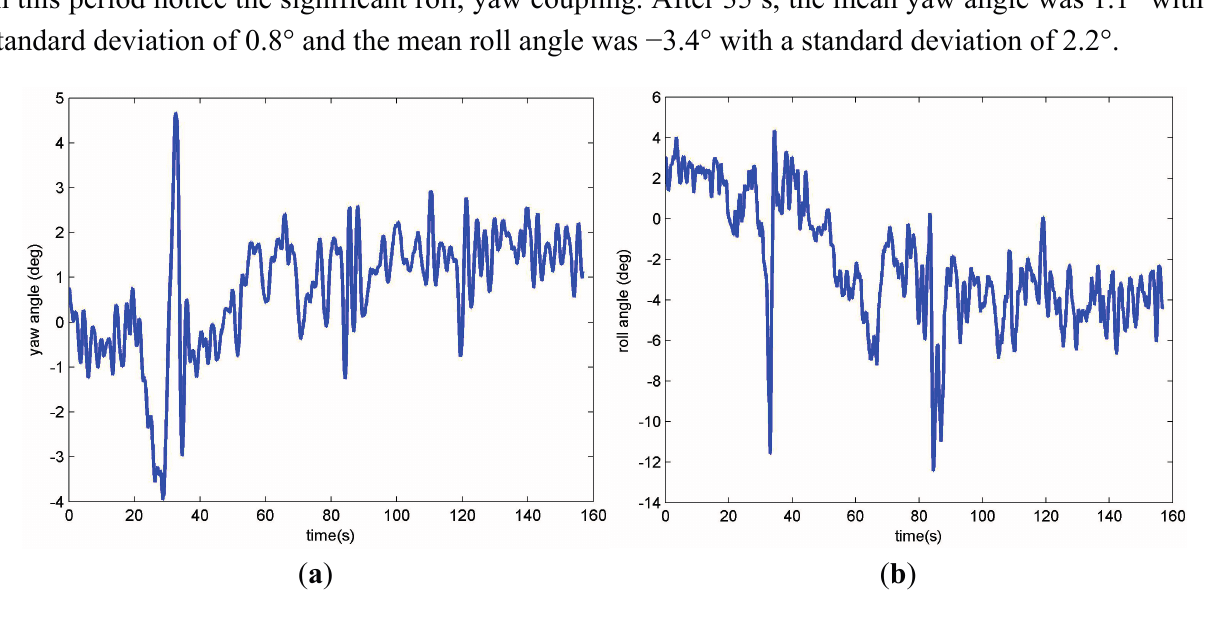
Figure 17. PD controller results for Smokey ( a ) yaw angle response ( b ) roll angle response